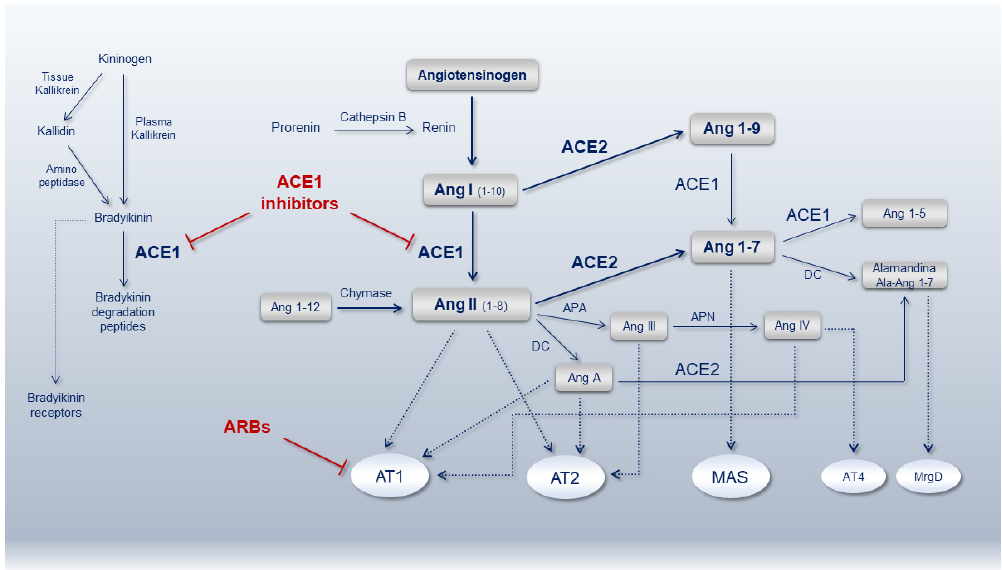
Figure 1. Schematic representation of the renin-angiotensin-system (RAS) pathway showing the main bioactive peptides and key receptors. ACE1, angiotensin-converting enzyme 1; ACE2, angiotensin- converting enzyme 2; Ang, angiotensin; AT1R, Ang-II type 1 receptor; AT2R, Ang-II type 2 receptor; ARBs, angiotensin receptor blockers; MAS, Mas receptor; AT4R, angiotensin receptor type 4; MrgD, MAS-related G protein-coupled receptor member D; APA, aminopeptidase A; APN, aminopeptidase N; DC, decarboxylase.